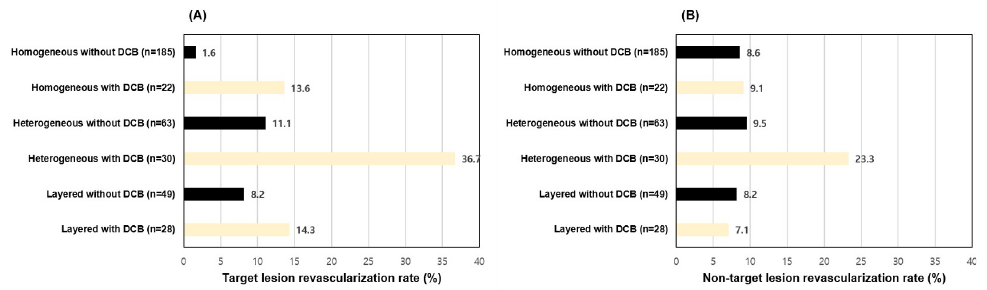
Fig 2. Target lesion revascularization rates (A) and non-target lesion revascularization rates (B) according to the neointimal characteristics and DCB angioplasty. DCB, drug-coated balloon.